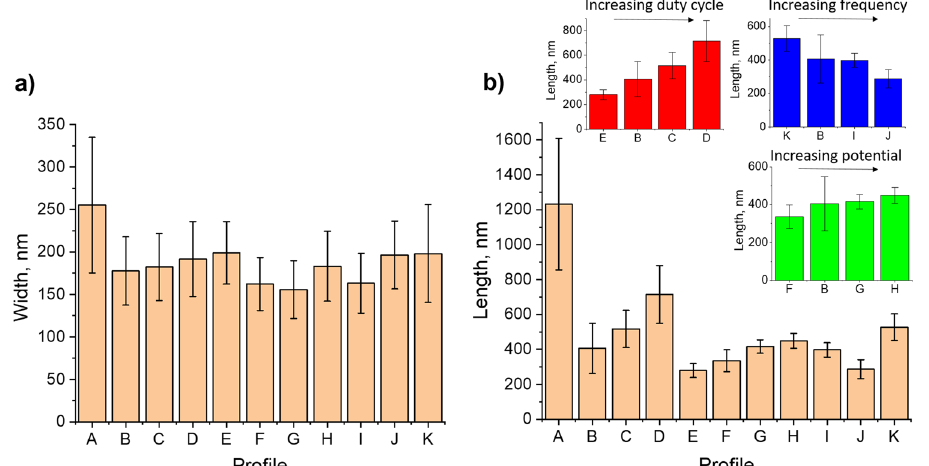
Figure 2. Statistical analysis of ZnO rod ( a ) widths and ( b ) lengths. See Table 1 for complete information on deposition